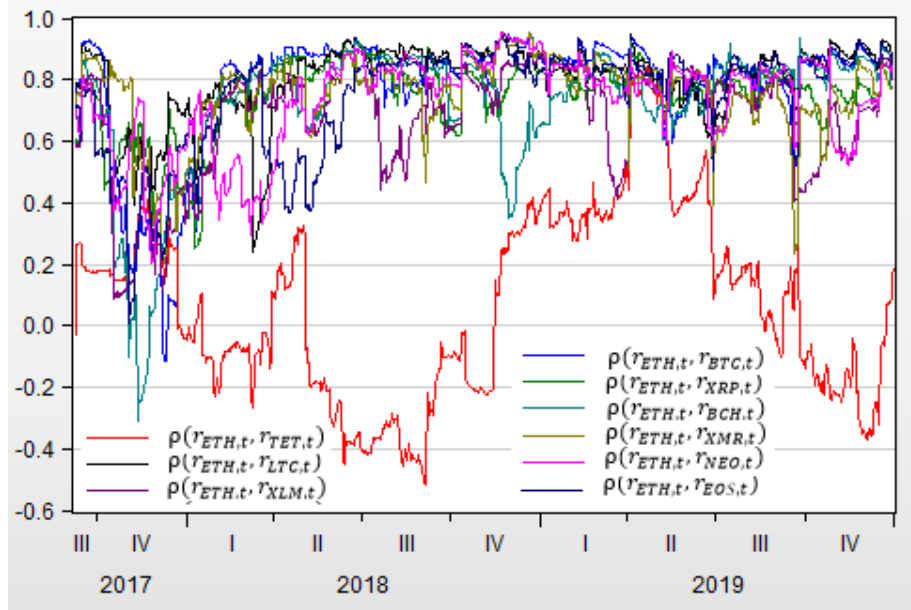
Figure 6. Curves of the DCC between Ethereum and the other eight cryptocurrencies for the pre- COVID-19 period.